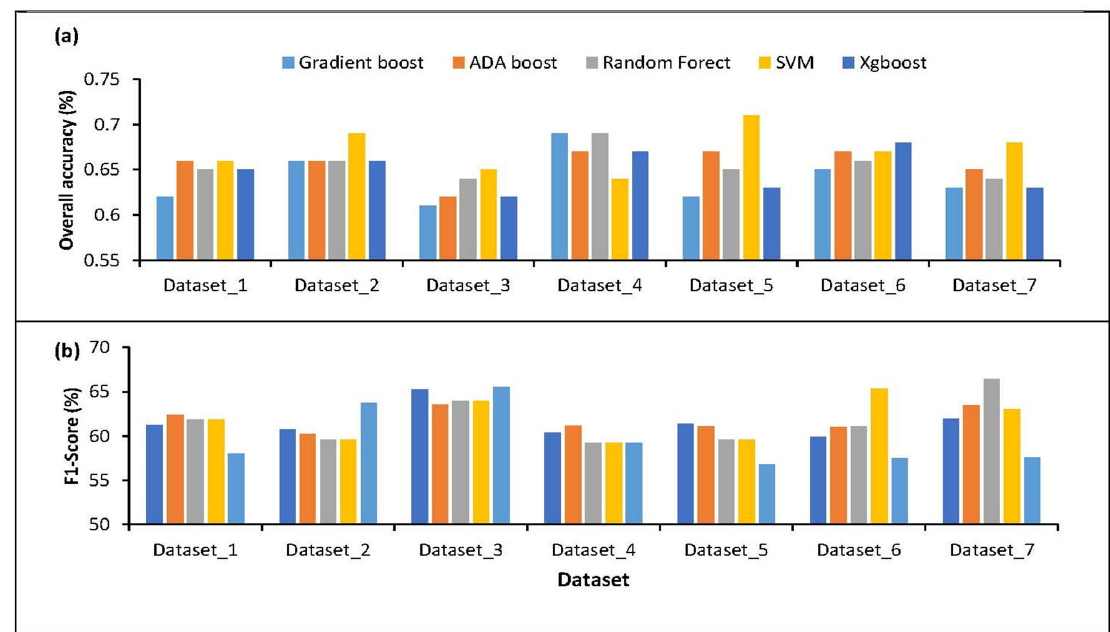
Figure 4. Spectral signature of fruit ‐ tree crops, and co ‐ existing land cover classes extracted from spectral Sentinel ‐ 2A algorithms image. The mapped classes are avocado (AV), banana (BN), bare soil (BS), guava (GV), macadamia nut (MN), mango (MG), pine tree (PT), built ‐ up (BU), water body (WB), and woody vegetation (WV).